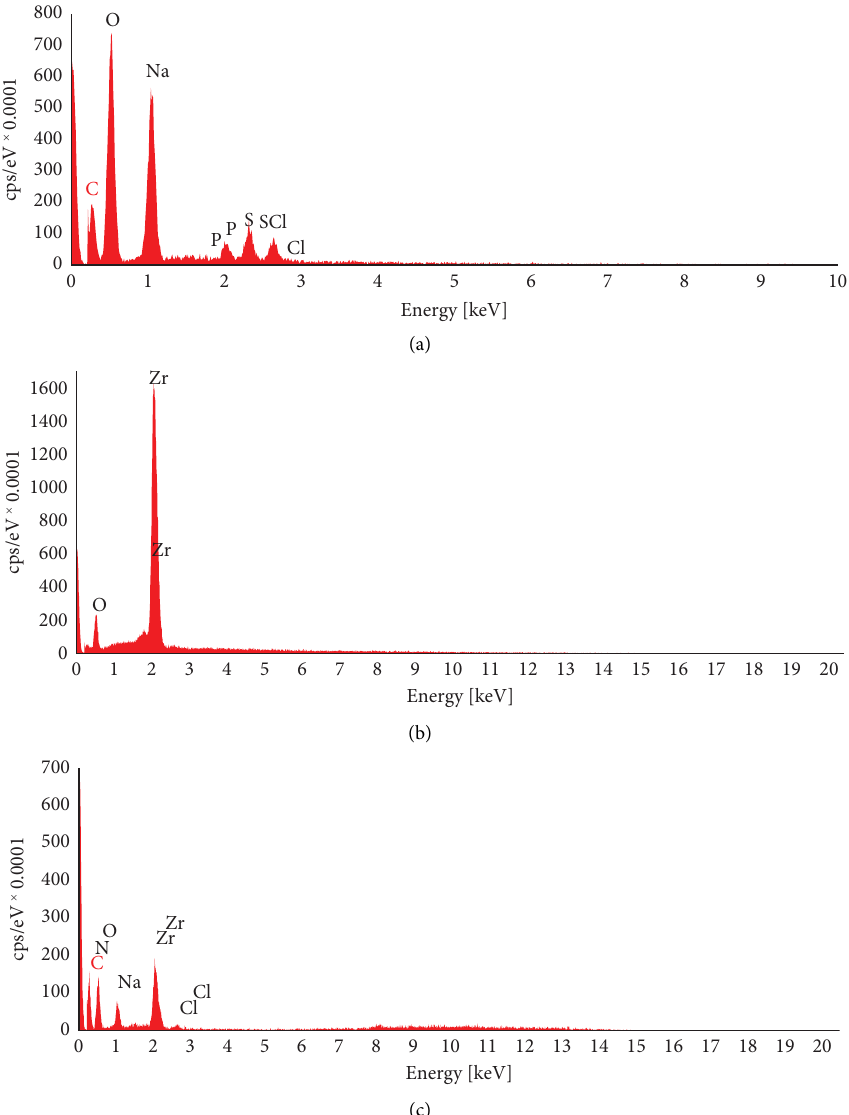
Figure 4: Energy-dispersive X-ray (EDX) spectra of alginate biopolymers (a), zirconia NPs (b), and alginate/zirconia nanocomposites